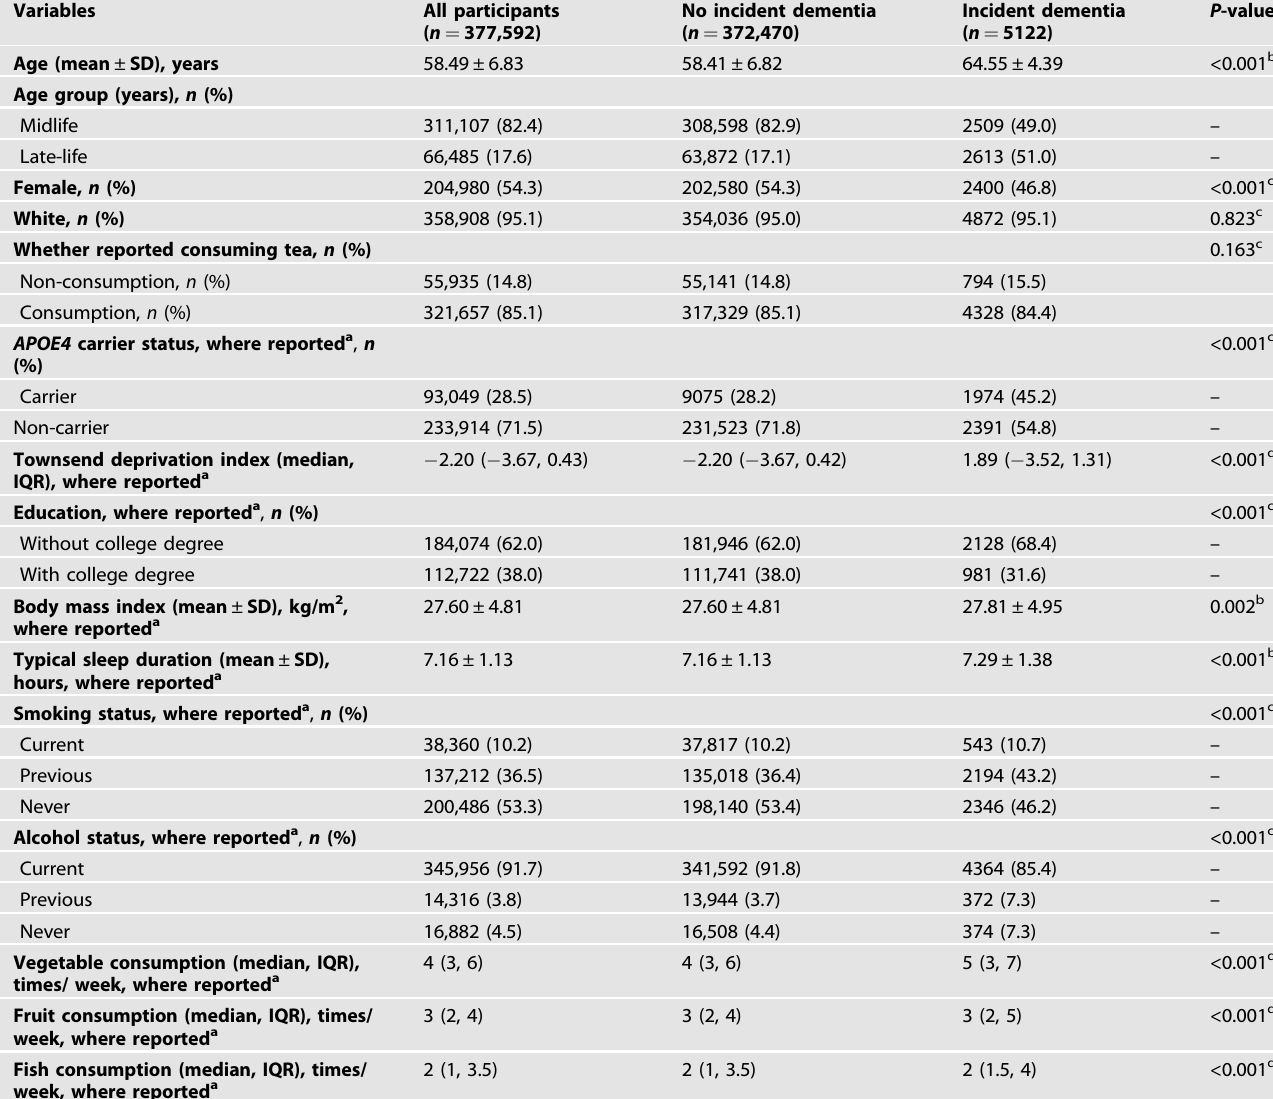
Table 1. Baseline characteristics of participants strati fi ed by the occurrence of